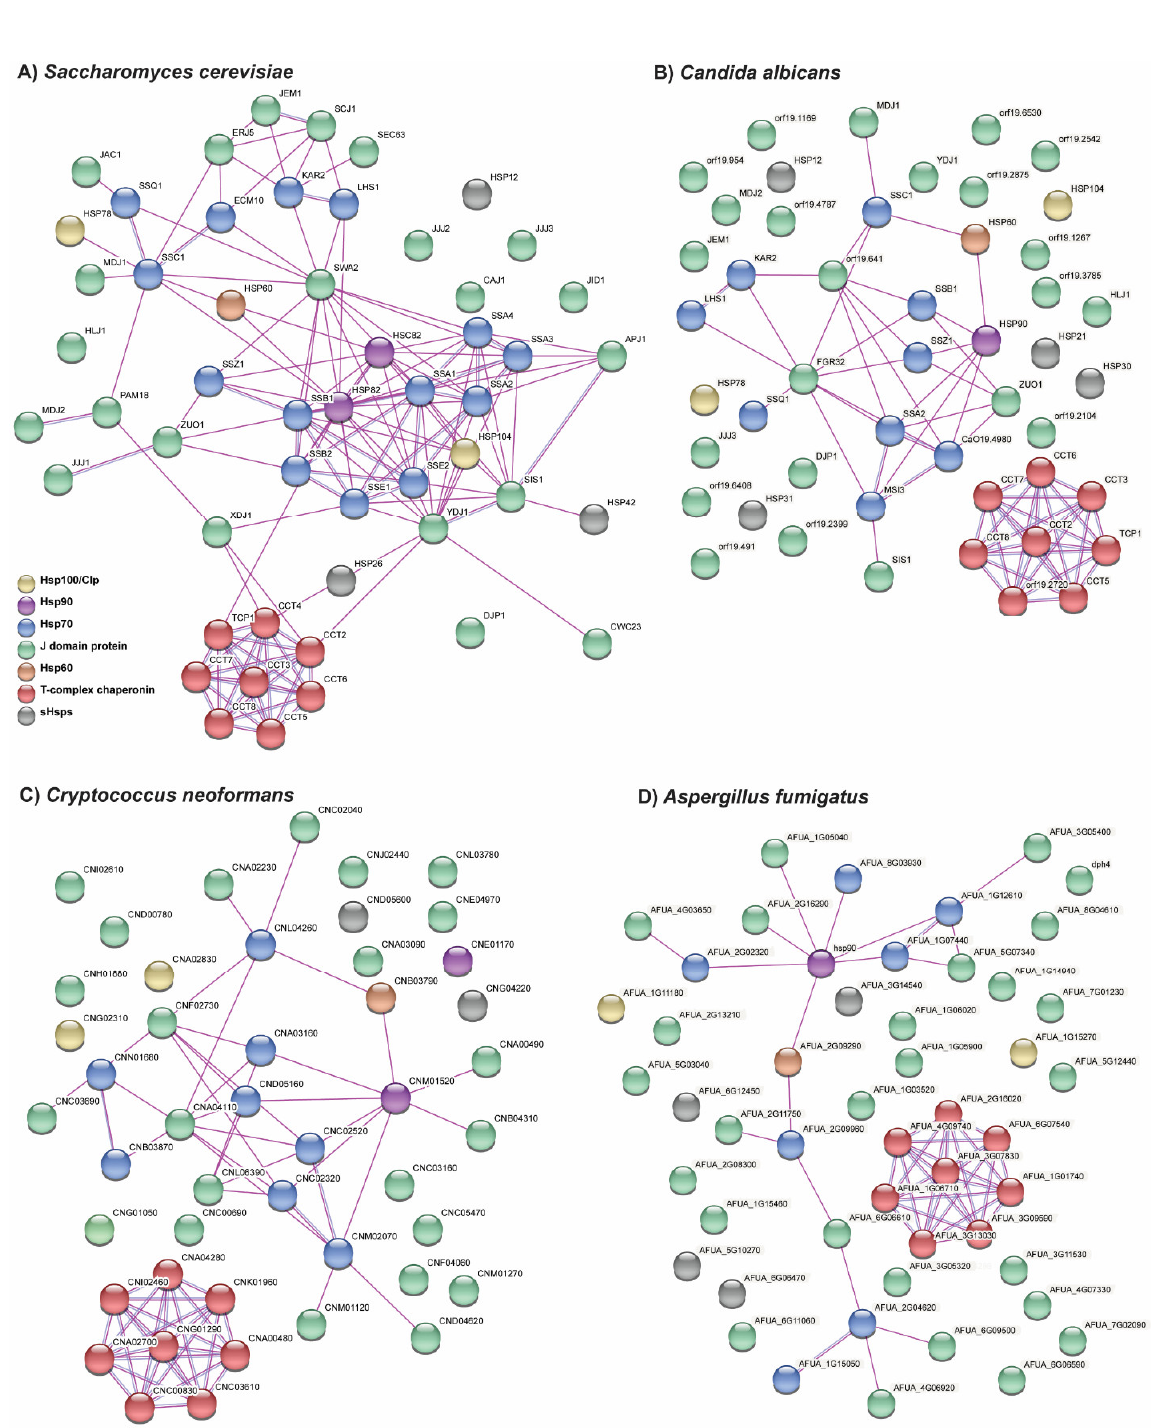
Figure 3. Network analyses of known and predicted interactions between chaperones in ( A ) S. cerevisiae, ( B ) C. albicans, ( C ) C. neoformans, and ( D ) A. fumigatus. STRING network analyses (https://string-db.org/, accessed on 5 January 2021) displaying the interactions between members of the Hsp100, Hsp90, Hsp70, JDP, sHsp, and chaperonin (Hsp60 and T-complex) families in S. cerevisiae and three of the major human fungal pathogens. Only experimentally